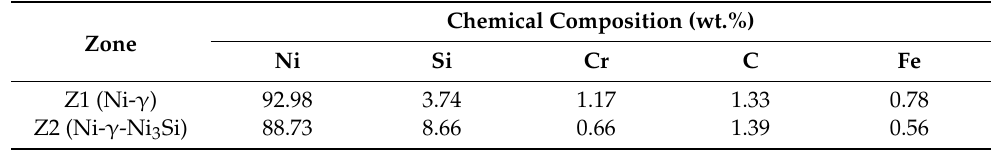
Table 2. SEM-EDS results of the as-cast NiSi3B2 alloy.